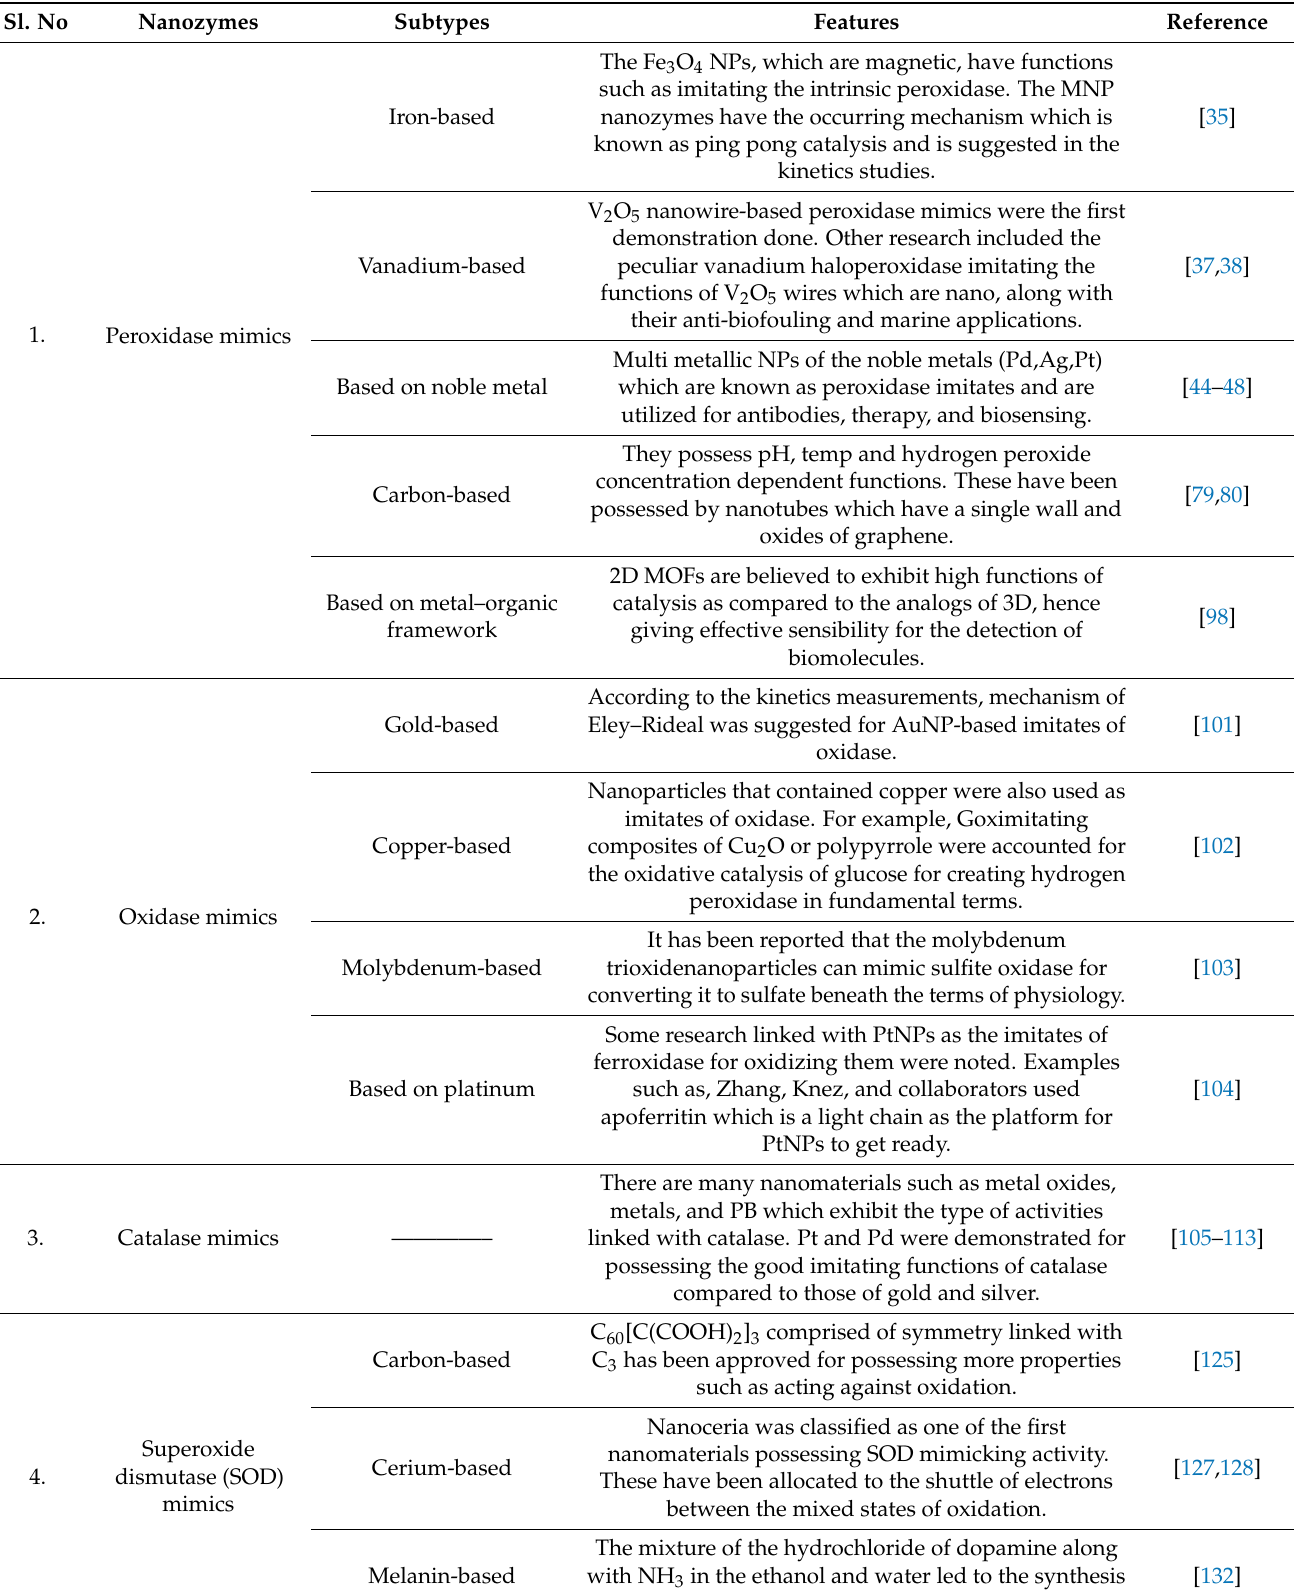
Table 1. Classification of